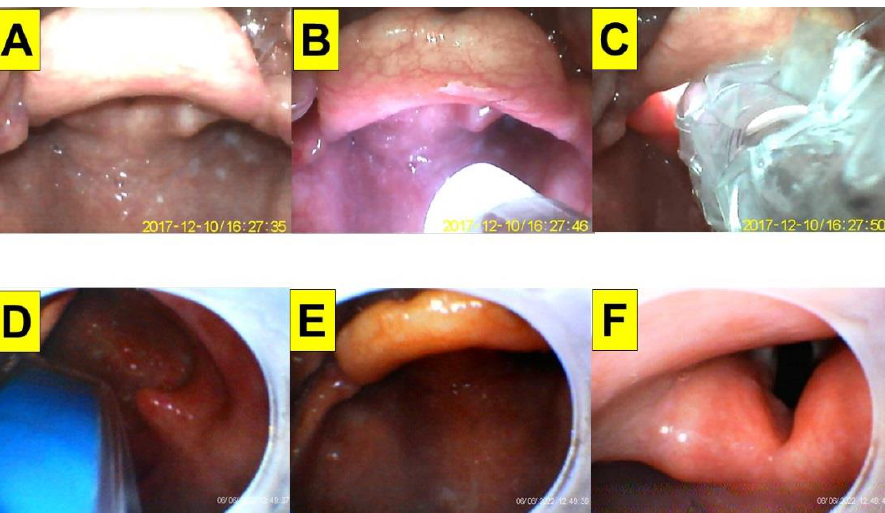
Figure 5. Application of video-twins technique in a patient with cervical spine injury. A 44-year-old woman with a BMI 23.4 kg/m 2 . Mallampati class III and Cormack-Lehane laryngoscopic view grade 2b: ( A – C ) videolaryngoscopic views; and ( D – F ) views from intubating stylet. Intubation